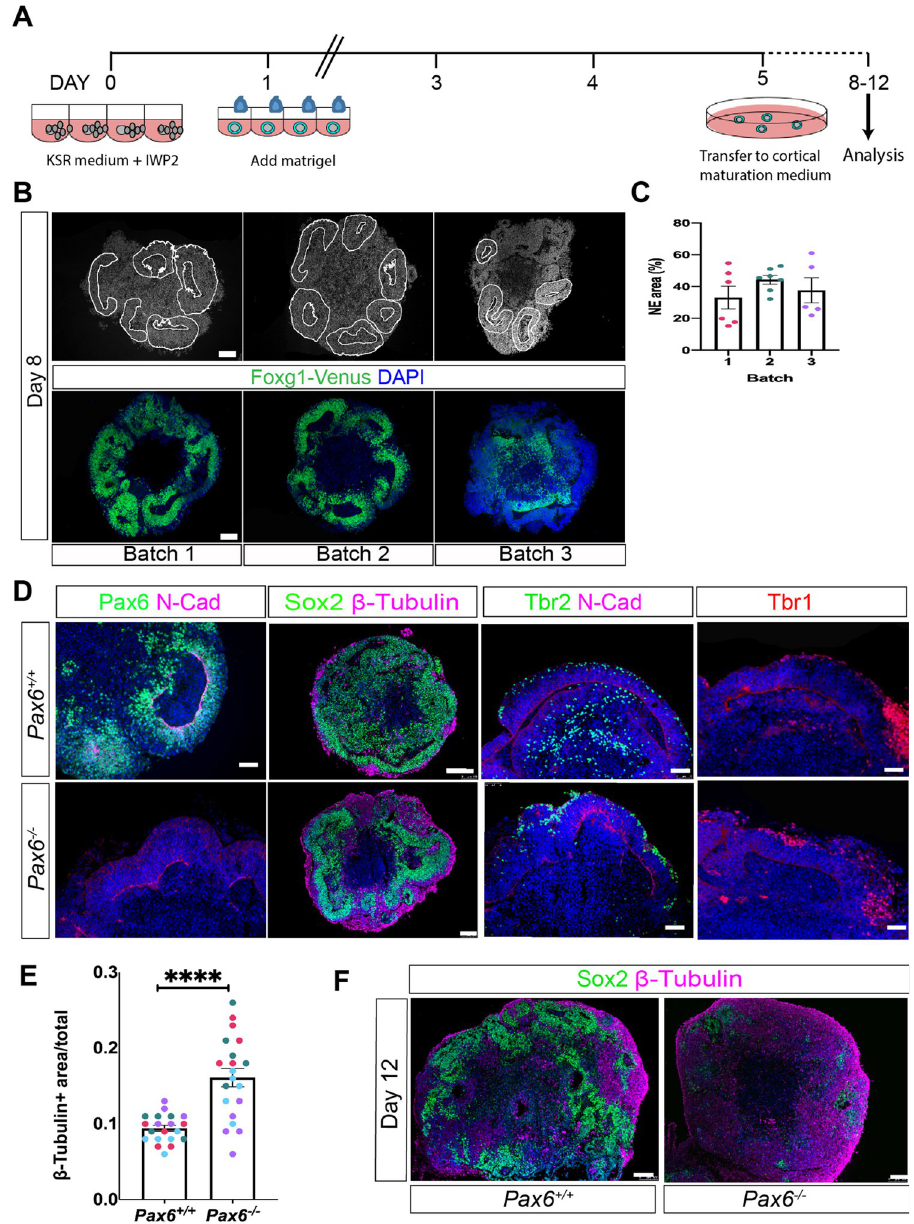
Fig 1. Characterisation of Pax6 -/- and Pax6 +/+ (Foxg1::Venus) control cerebral organoids. (A) Schematic outline of the organoid differentiation protocol (Eiraku et al., 2008). (B) Upper panels: DAPI-stained sections of day 8 organoids from three separate differentiation batches highlighting neuroepithelial regions of the organoids used for quantitation (outlined by white lines). Lower panels: Foxg1::Venus expression (green) in organoids from the same three batches. Nuclei are counterstained with DAPI (blue). (C) Graph showing proportion of organoid area that is occupied by neuroepithelial tissue. n = 5–6 organoids in each of 3 independent batches. Data points are colour-coded to indicate separate batches. (D) Immunostaining of day 8 cerebral organoids showing expression of neuroepithelial marker N- cadherin, basal progenitor and early neuronal marker Tbr2 (Eomes), cortical neuron marker Tbr1 and neuronal marker in Pax6 +/+ control (top row) and Pax6 -/ - mutant organoids (bottom row). (E) Graph showing proportion of neuroepithelial area within day 8 Pax6 -/ - and control organoids that stained positively for β -tubulin+ expression. Coloured spots indicate separate batches of organoids. n = 20 control and 20 mutant organoids from 4 independent batches. Student’s t-test indicated a significant increase in β -tubulin staining in mutant organoids, p < 0.01. (F) Immunostaining for Sox2 and β -tubulin in day 12 Pax6 -/ - and control organoids. Scale bars in panels B,D,F: 50 μ m.